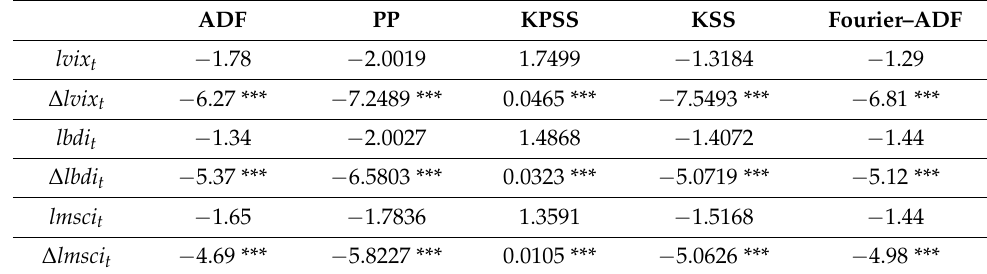
Table 2. Results of Linear and Nonlinear Unit Roots and Stationarity Tests.